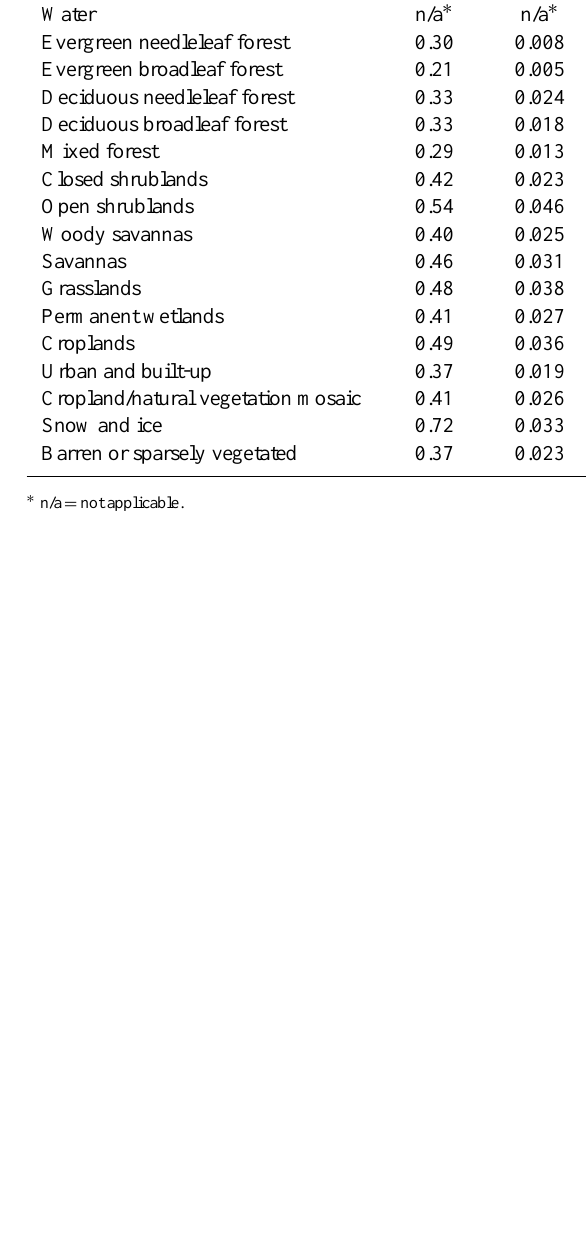
Table A1 provide mean ( µ ) and standard deviation ( σ ) of surface albedo for each land class type using Sect. 2.2